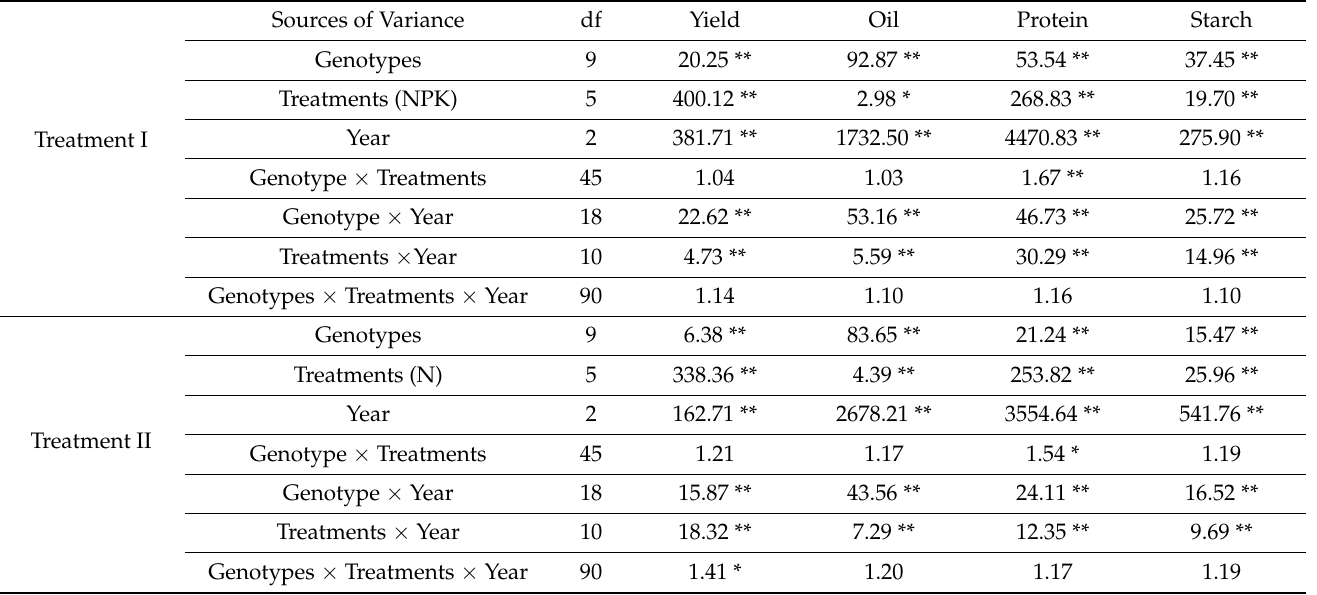
Table 3. Results of variance analysis based on fertilizer treatments in hybrids in years.